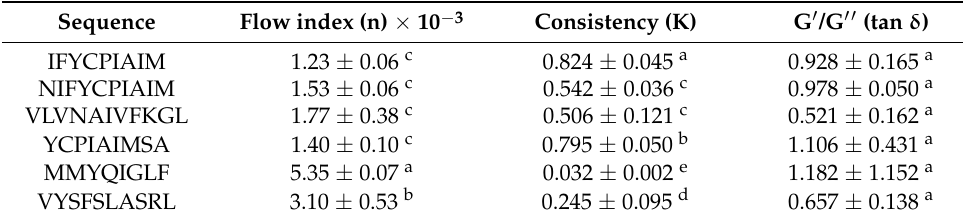
Table 2. Flow behavior of the ovalbumin-derived peptide